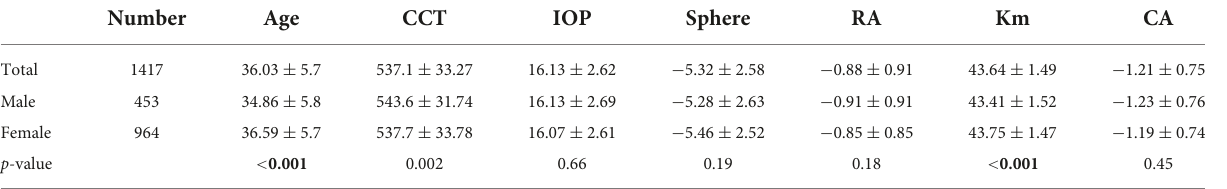
TABLE 1 Ocular parameters of patients stratified by gender.